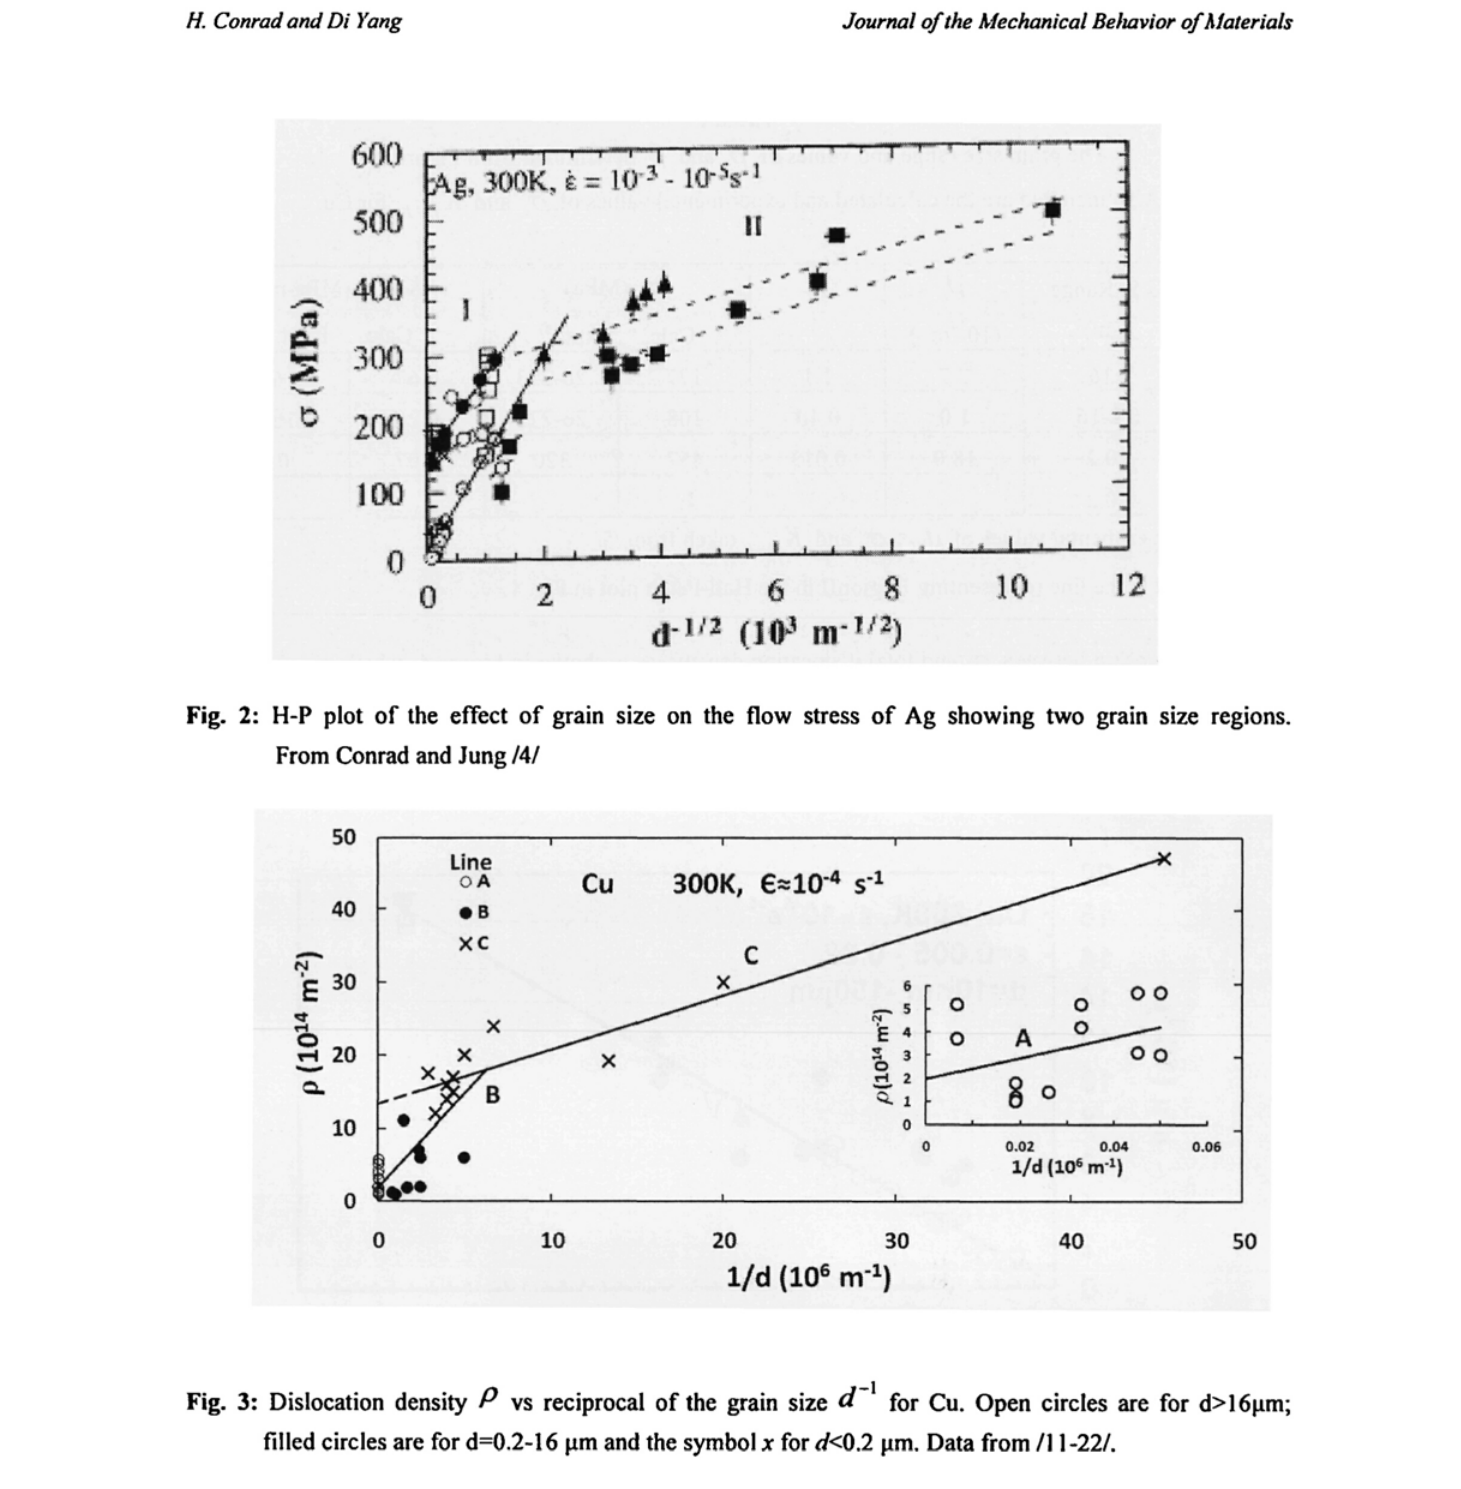
Fig. 3: Dislocation density P vs reciprocal of the grain size d for Cu. Open circles are for d>16μm; filled circles are for d=0.2-16 μηι and the symbol χ for d<Q.2 μπ\. Data from /l